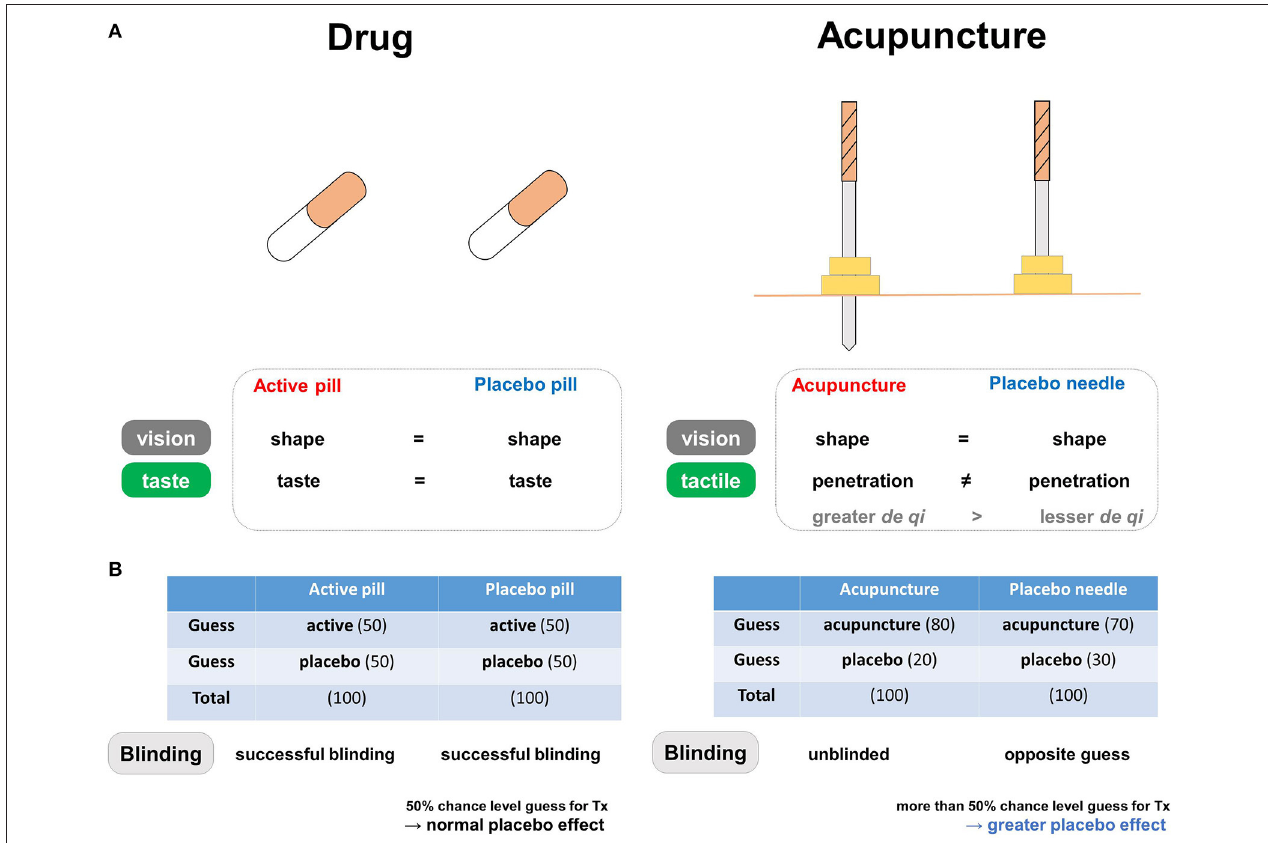
FIGURE 2 | The blinding components of placebo needles . (A) Differences in blinding characteristics between placebo needles and placebo pills. In pharmaceutical trials, the similar shapes and tastes of the active and placebo pills prevent patients from correctly guessing whether they are in the treatment group. In acupuncture trials, placebo needles are similar to real acupuncture devices in terms of shape, but not in terms of penetration when applied to the skin. (B) Both active and placebo pills have a 50% chance level of being perceived as active in the pharmaceutical trials, whereas both real and placebo acupuncture causes a tendency to believe that they are receiving active treatment in the acupuncture trials. Differences in blinding scenarios for placebo needles and placebo pills. In pharmaceutical trials, successful blinding in the treatment and placebo groups results in patients making random guesses about whether they are receiving active or placebo pills. Acupuncture trials involve different blinding scenarios: “unblinded participants” in the real acupuncture group and participants making “opposite guesses” in the placebo needle group. Due to this unique pattern of blinding, individuals more often respond to placebo needles because they are more likely to believe they are receiving active treatment (i.e., opposite